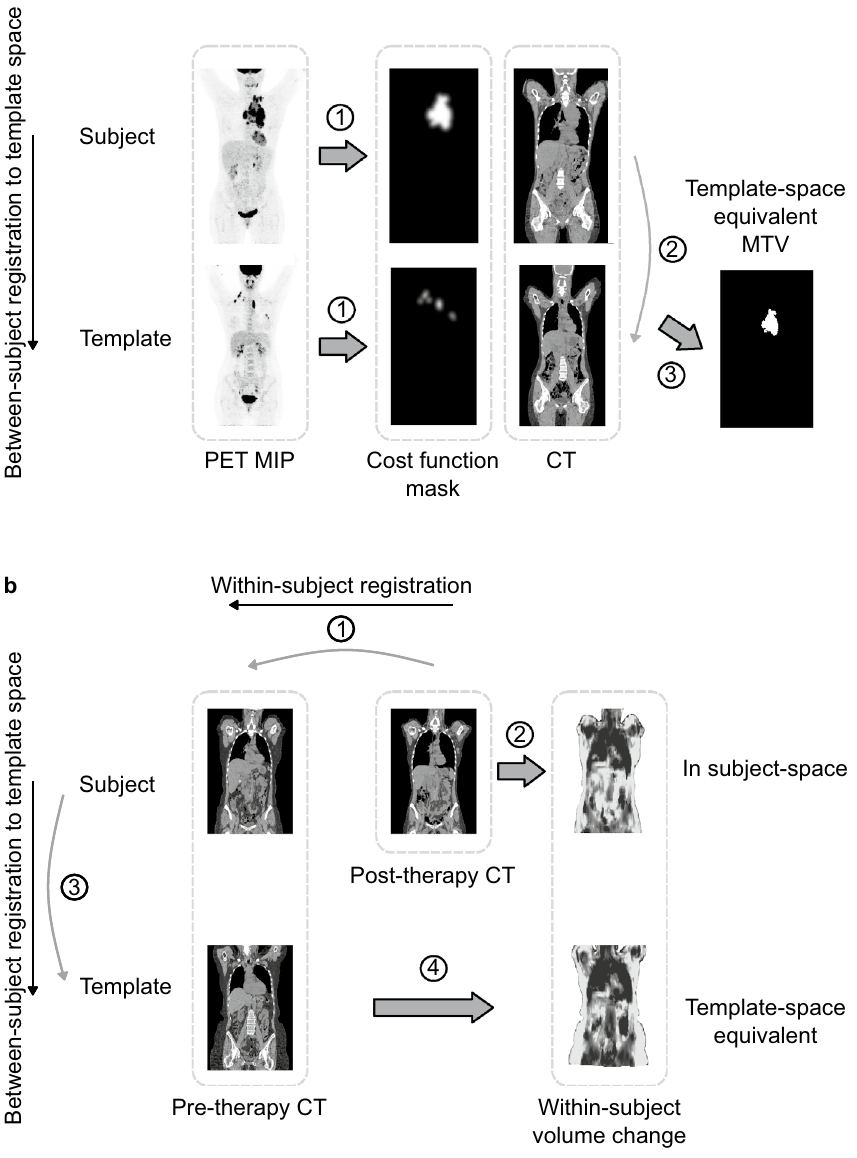
Figure 2. Application of the image registration method to the images of ( a ) classical Hodgkin lymphoma (cHL) and ( b ) head and neck cancer (HNC) patients. Each subfigure shows the output of a single subject and was repeated for all subjects in each dataset respectively. In ( a ), each cHL subject’s CT image is first registered to the template subject’s CT with cost function masking using the MTV segmentations to define voxels that contributed less to the matching cost. Next, each subject’s MTV is transferred to template space using the transform from between-subject registration to generate a template-space equivalent MTV. In ( b ), each HNC subject’s post-therapy CT scan is first registered to its pre-therapy scan. The Jacobian determinant (local volume change map) of the resulting within-subject transform is then generated. Next, the subject’s pre-therapy scan is registered to the template subject’s pre-therapy scan and the resulting between-subject transform is used to generate a template-space equivalent local volume change map. MIP maximum intensity projection, MTV metabolic tumor